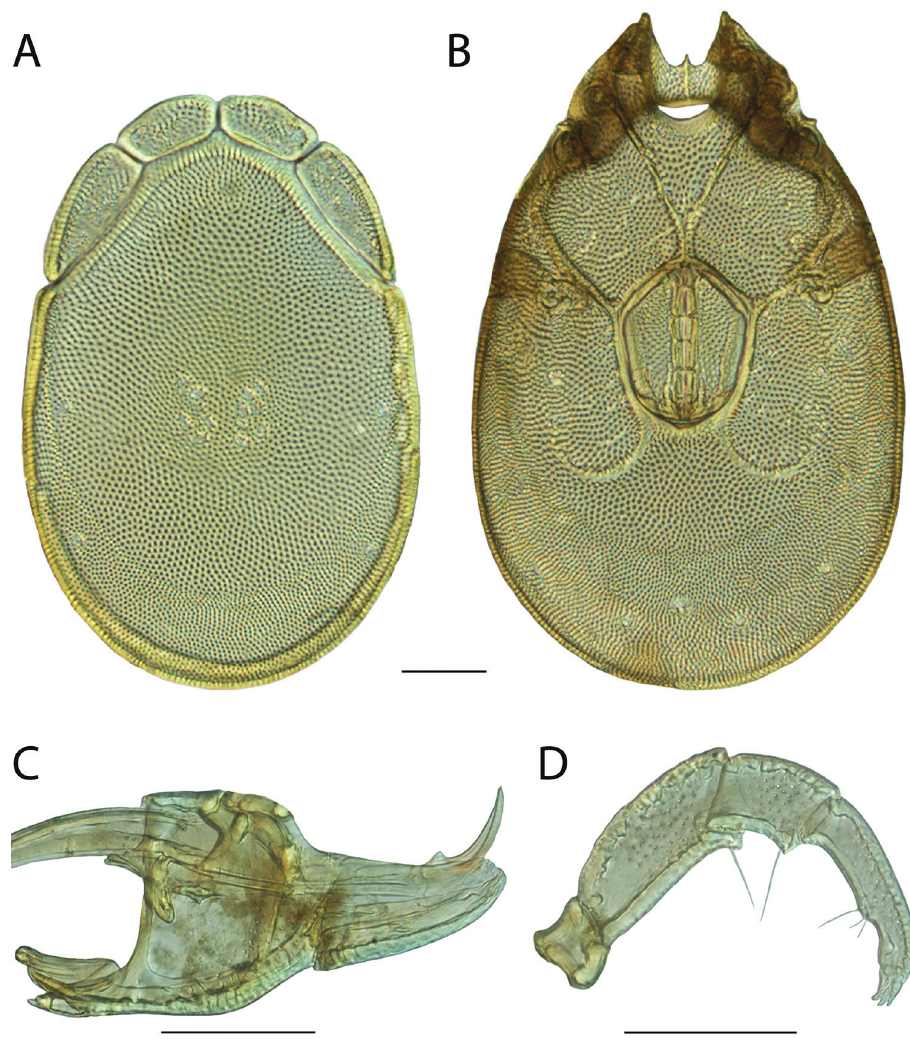
Figure 94. Torrenticola hoosieri sp. n. female: A dorsal plates B venter (legs removed) C subcapitulum, note damaged rostrum D pedipalp (setae not accurately depicted). Scale = 100 µm.